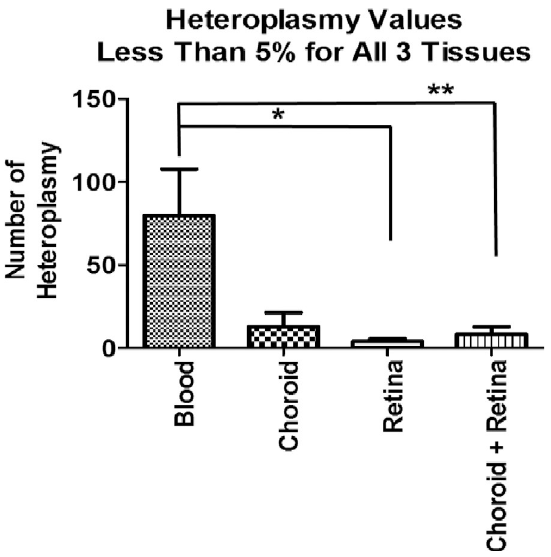
Fig 2. Number of heteroplasmy SNPs found in blood, choroid, and retina.